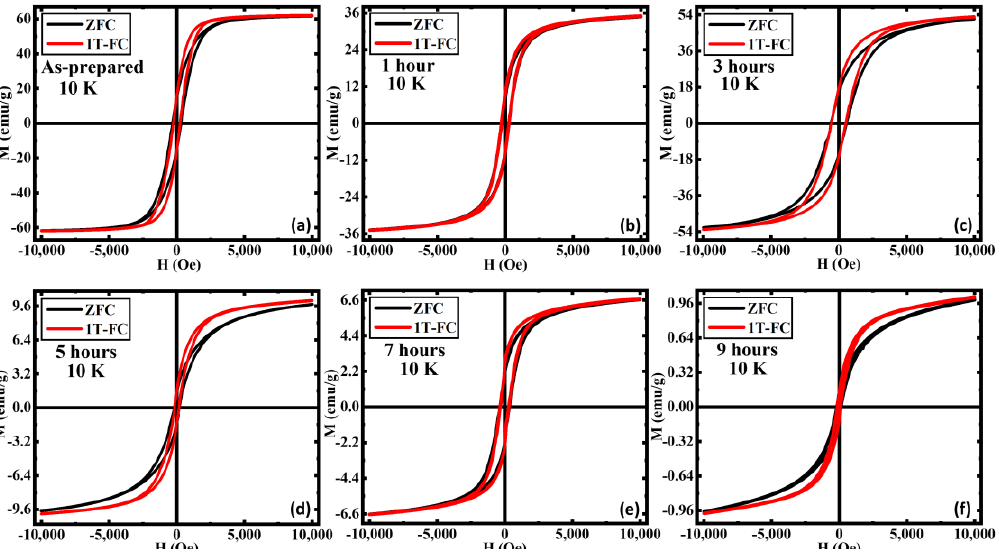
Figure 5. Magnetic hysteresis loops M(H) recorded with ZFC and FC protocols in an applied field of 1 T for ( a ) as-prepared, ( b ) annealed for 1 h, ( c ) annealed for 3 h, ( d ) annealed for 5 h, ( e ) annealed for 7 h, and ( f ) annealed for 9 h iron oxide nanorods at 10 K. For comparison, the M(H) data of ( a ) were taken from Ref. [33].